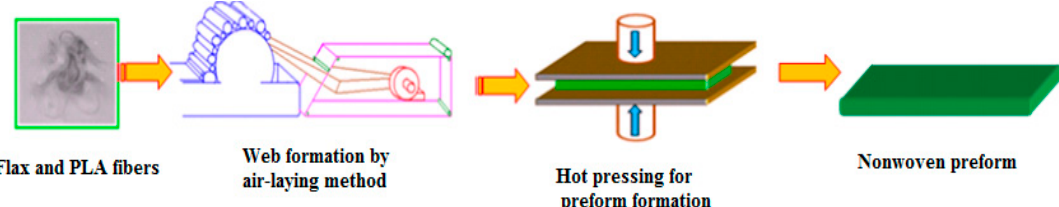
Figure 1. Schematic diagram of random flax preform fabrication process route.